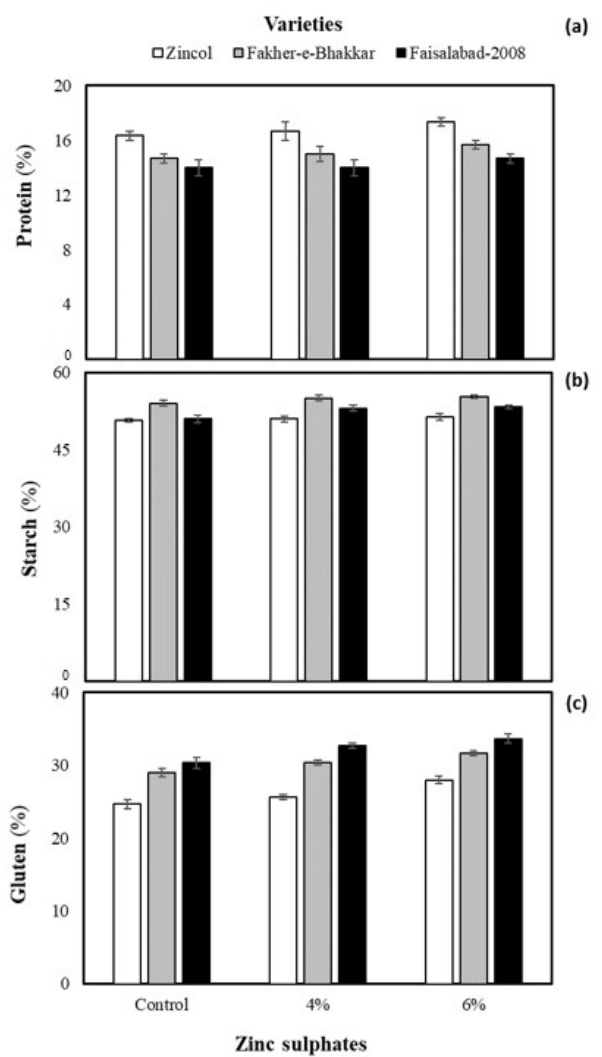
Figure 3. Interactive effect of varieties × zinc sulphates on the nutritional quality of bread wheat grains grown under a semi-arid environment. ( a ), protein; ( b ), starch; ( c ), gluten. Error bars represent the standard error (n = 5).